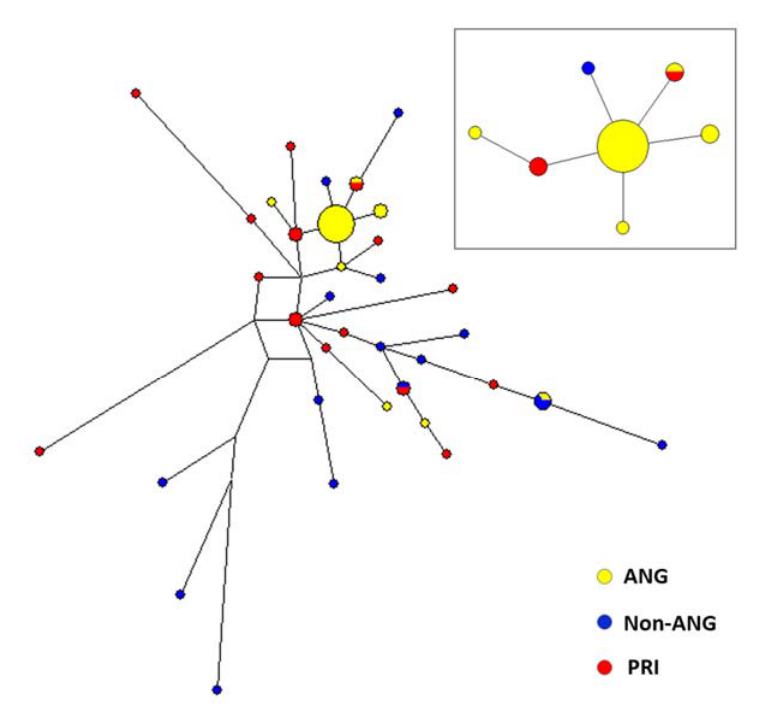
Figure 4. Network representing the haplotype variation in African-derived Y-chromosomes from S ã o Tom é and Pr í ncipe. Haplotypes were defined by using 10 microsatellite loci (DYS19, DYS389I, DYS389II, DYS390, DYS391, DYS392, DYS393, DYS437, DYS438, DYS439). Locus DYS385 was excluded from the network because it is duplicated. The inset shows the descent cluster centered around the most frequent haplotype in the Angolares. Haplotypes from the Angolares (ANG)